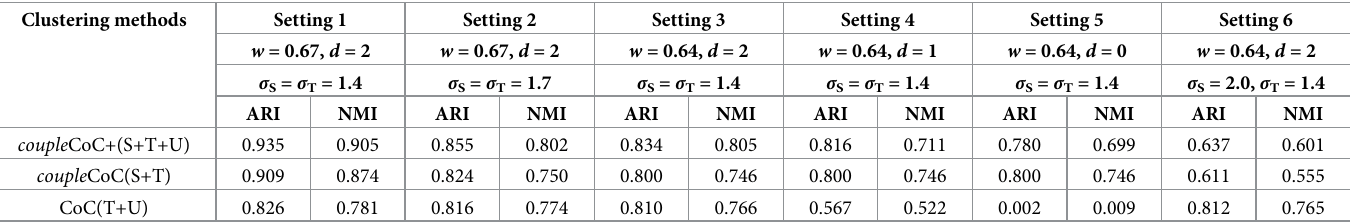
Table 2. The simulation results for clustering the target data in 30 independent runs are summarized. Note that the capital letters in the brackets represent the input data matrices for the corresponding methods: S represents source data, T and U represent the sub-matrices for the linked and unlinked features in target data, respectively. couple CoC+ and couple CoC utilize both the source data and the target data as input, and they produce clustering results of the cells in source data and target data simulta- neously; CoC is implemented on only target data, and it produces clustering results of the cells in target data. We then summarize the clustering results by calculating ARI and NMI for target